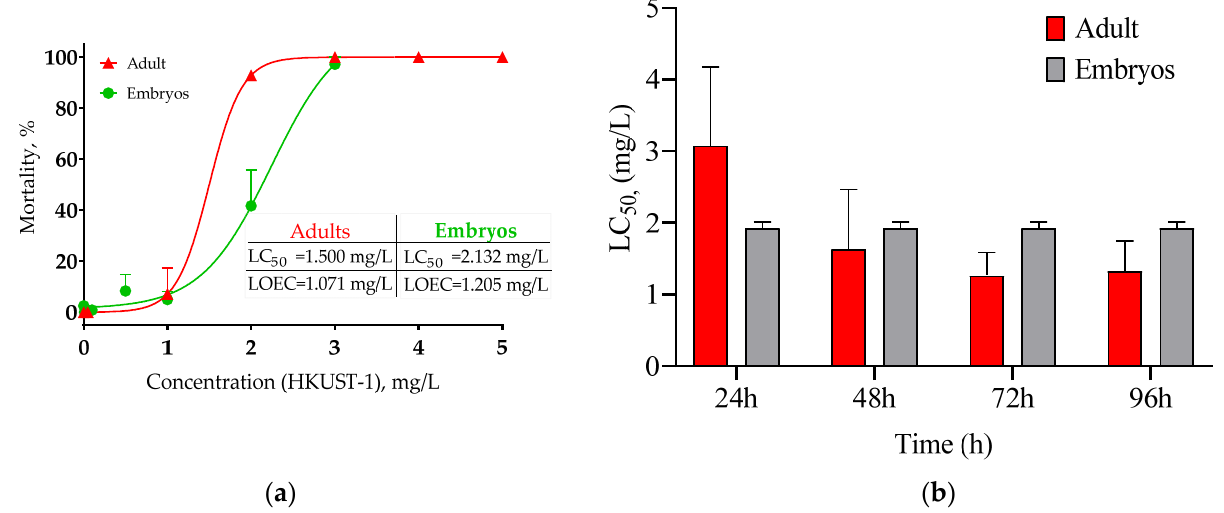
Figure 4. Mortality ( a ) and LC 50 data ( b ) of HKUST-1 (Cu-MOF) particles in embryos and adult zebrafish over 96 h expo- sure.